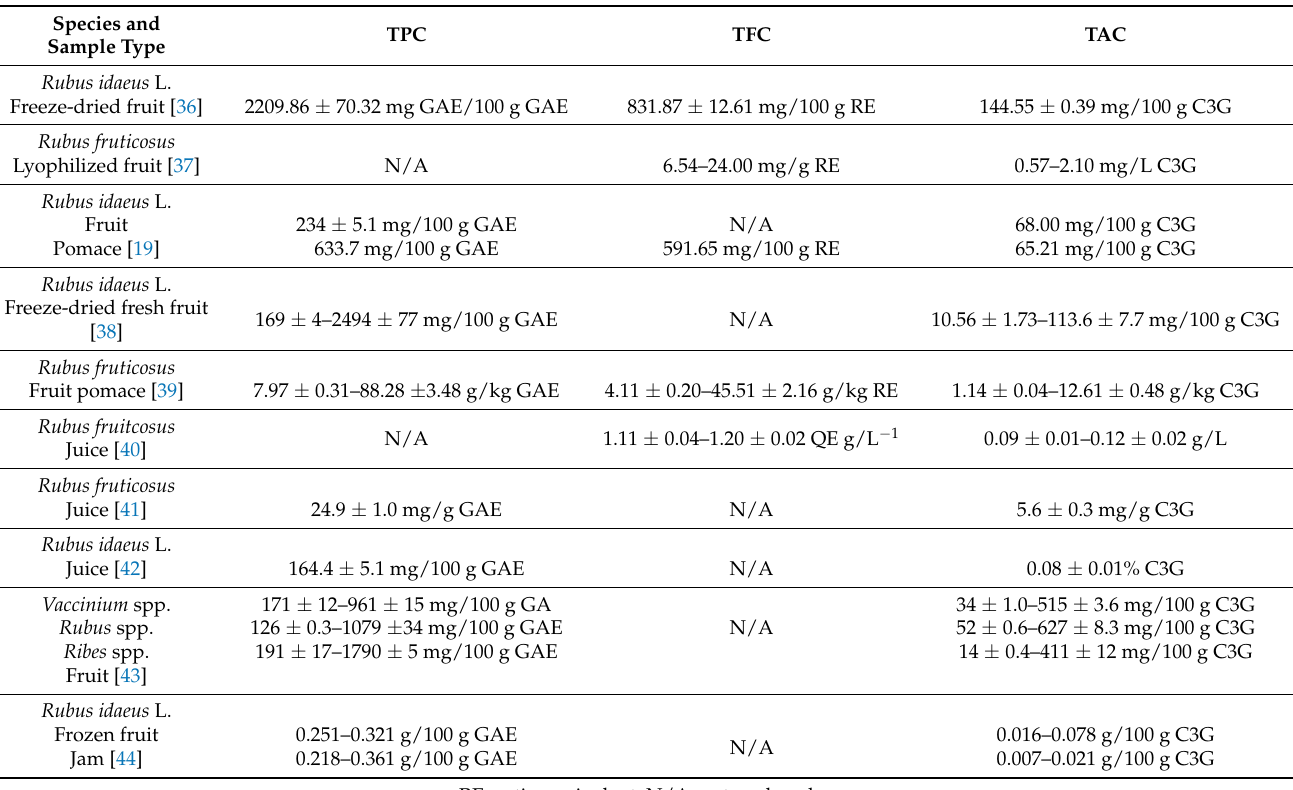
Table 2. Data from the literature on total phenolic, flavonoid, and anthocyanin content of the RFP, whole fruit, and its